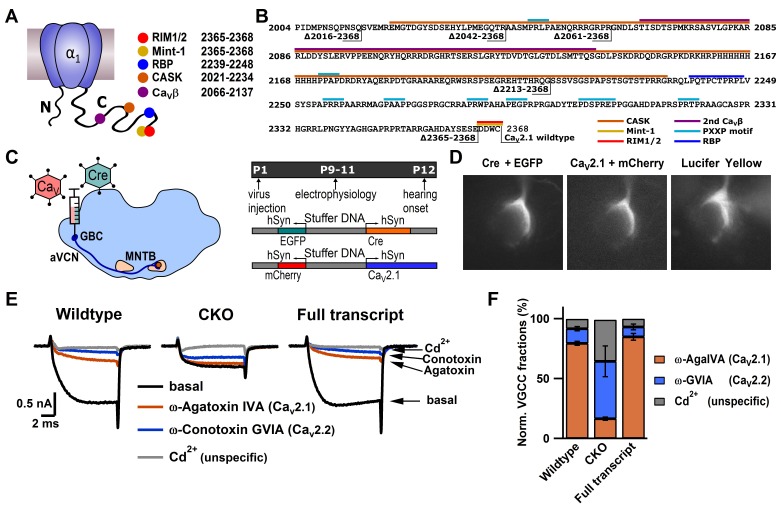
CaV2.1 can be selectively ablated and functionally rescued at the calyx of Held.(A) Cartoon depicting CaV2.1 α1 subunit distal C-terminal interaction partners. (B) Amino acid sequence of the distal Cav2.1 C-terminus indicating interaction sites and truncation mutants. (C) left: Schematic view of stereotactic surgery to inject/coinject HdAd vectors expressing Cre + eGFP and CaV2.1 constructs + mCherry into the aVCN at age P1. Right: top: Experimental timeline from virus injection at P1 to electrophysiological recordings at P9-P11 prior to the onset of hearing (P12). Middle and bottom: schematic view of the viral constructs used, expressing either Cre + eGFP or CaV2.1 constructs + mCherry, respectively, driven by individual promotors. (D) Calyx of Held terminals transduced with Cre + eGFP (top) and CaV2.1 + mCherry (middle). eGFP and mCherry signals overlap with those of a calyx of Held loaded with Lucifer Yellow via a patch pipette (bottom). (E) Pharmacological isolation of presynaptic CaV2 isoforms in wildtype, CKO and CaV2.1 full transcript rescue calyxes. Traces in absence of any blockers (black), after blocking CaV2.1 fraction with 200 nM ω-AgaIVA (brown), after blocking CaV2.2 fraction with 2 µM ω-GVIA (blue) and after blocking all CaV2 channels with 50 µM Cd2+ (gray). (F) Relative CaV2 current fractions in wildtype, CKO and CaV2.1 full transcript rescue calyxes (n = 3 for each condition).